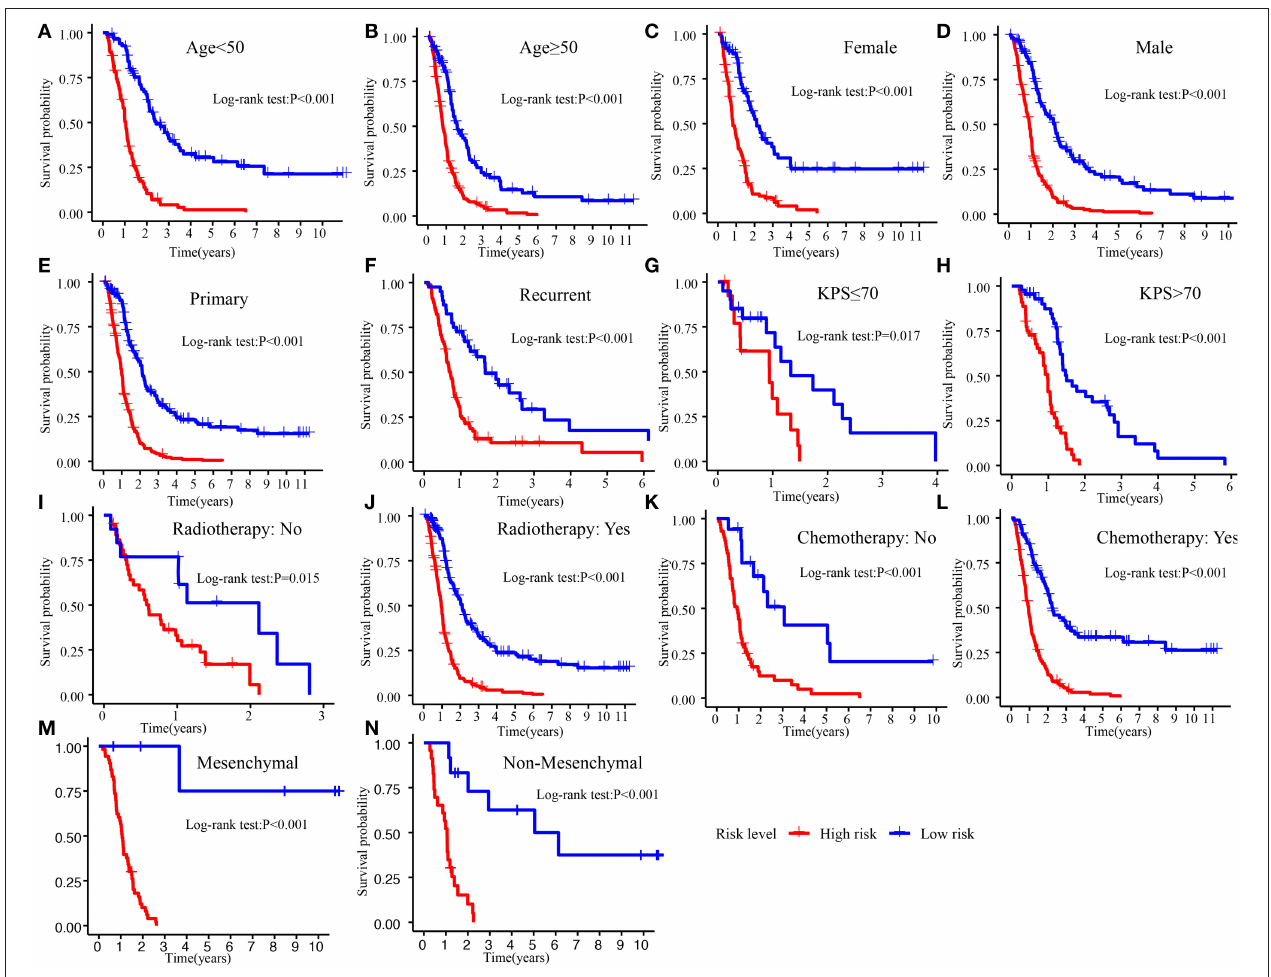
FIGURE 4 | Survival difference between high- and low-risk patients in different subgroup. (A) Age < 50. (B) Age > 50. (C) Female. (D) Male. (E) Primary tumor. (F) Recurrent tumor. (G) KPS ≤ 70. (H) KPS > 70. (I) Radiotherapy: No. (J) Radiotherapy: Yes. (K) Chemotherapy: No. (L) Chemotherapy: Yes. (M) Mesenchymal. (N) Non-mesenchymal. KPS,